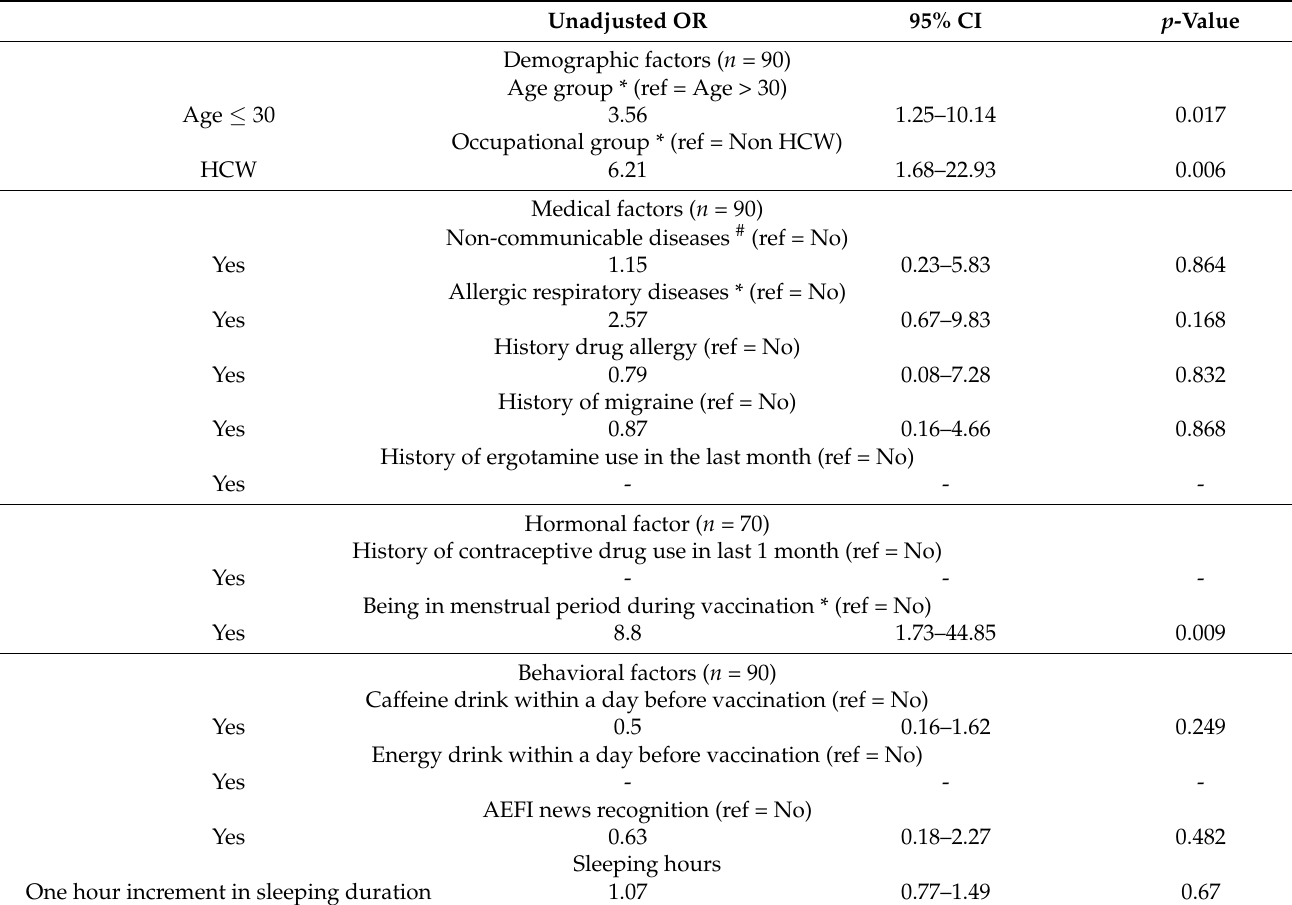
Table 4. Univariable conditional logistic regression analysis to estimate the odds of ISRR.